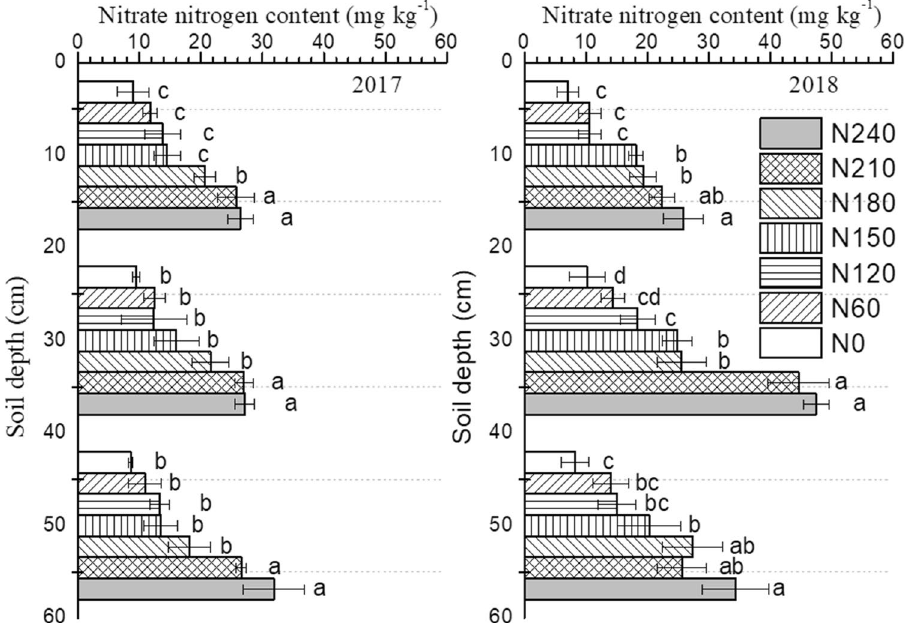
Figure 3. Nitrate nitrogen contents at different soil depths in treatments with different nitrogen fertilizer rates. Different letters in the same soil depth indicate significant differences (P < 0.05) among treatments in the same year. Nitrogen balance (amount of nitrogen input minus amount of plant nitrogen uptake) calculated for potato treated with different nitrogen fertilizer